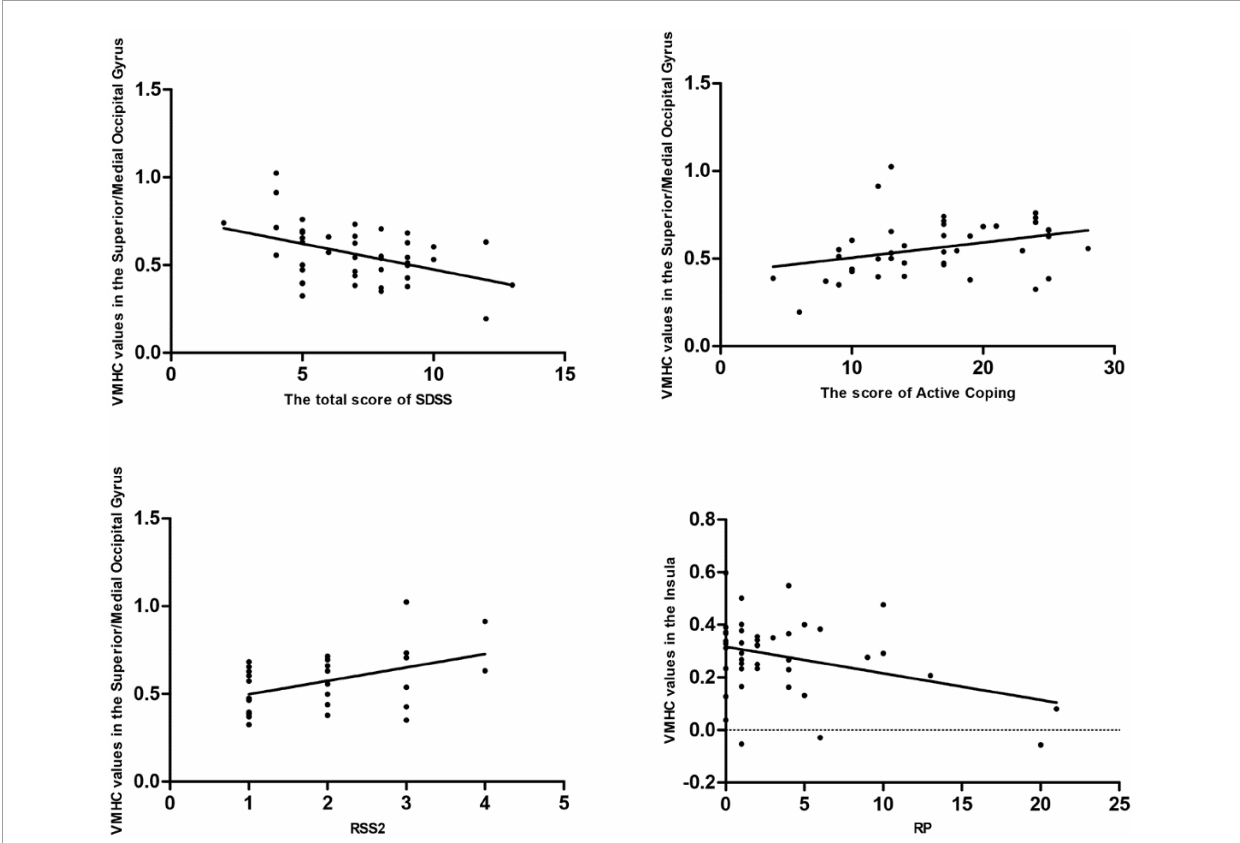
FIGURE3 Pearson/Spearman correlations. Correlations were found as follows: (1) The VMHC values in the superior/middle occipital gyrus and the SDSS total scores ( r = –0.441, p = 0.003, df = 41); (2) the VMHC values in the superior/middle occipital gyrus and the scores of Active Coping ( r = 0.332, p = 0.032, df = 41); (3) the VMHC values in the superior/middle occipital gyrus and RSS2 ( r = 0.443, p = 0.018, df = 27); and (4) the VMHC values in the insula and RP ( r = –0.341, p = 0.027, df = 41). VMHC, voxel-mirrored homotopic connectivity; SDSS, social function defect screening scale;